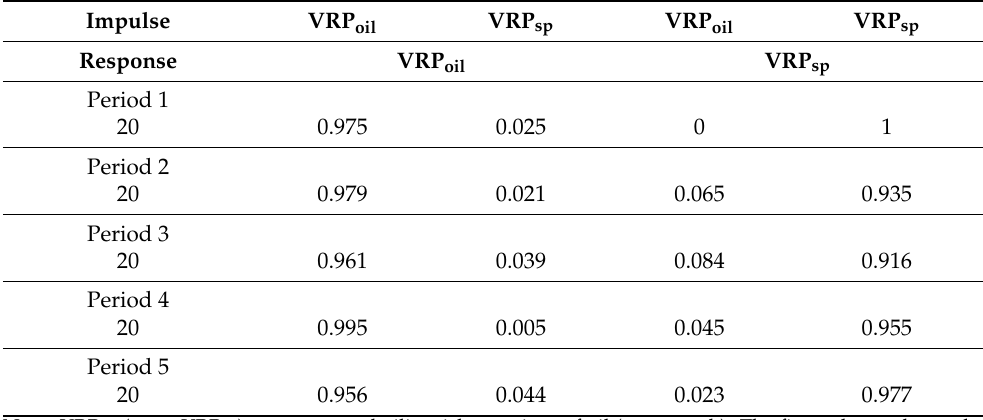
Table 9. Variance decompositions with order VRP sp before VRP oil . (Effects on the 20th trading day after the